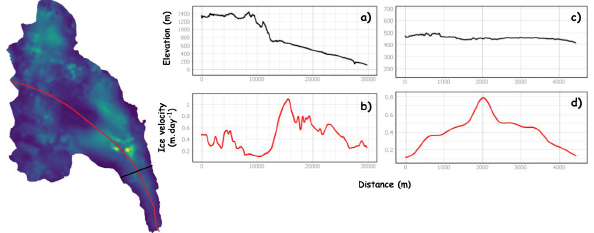
Figure 9. Tyndall Profile plots of (a) elevation at the top-down longitudinal section; (b) ice velocity at the top-down longitudinal section; (c) elevation at the left-right cross section; (d) ice velocity at the left-right cross section.